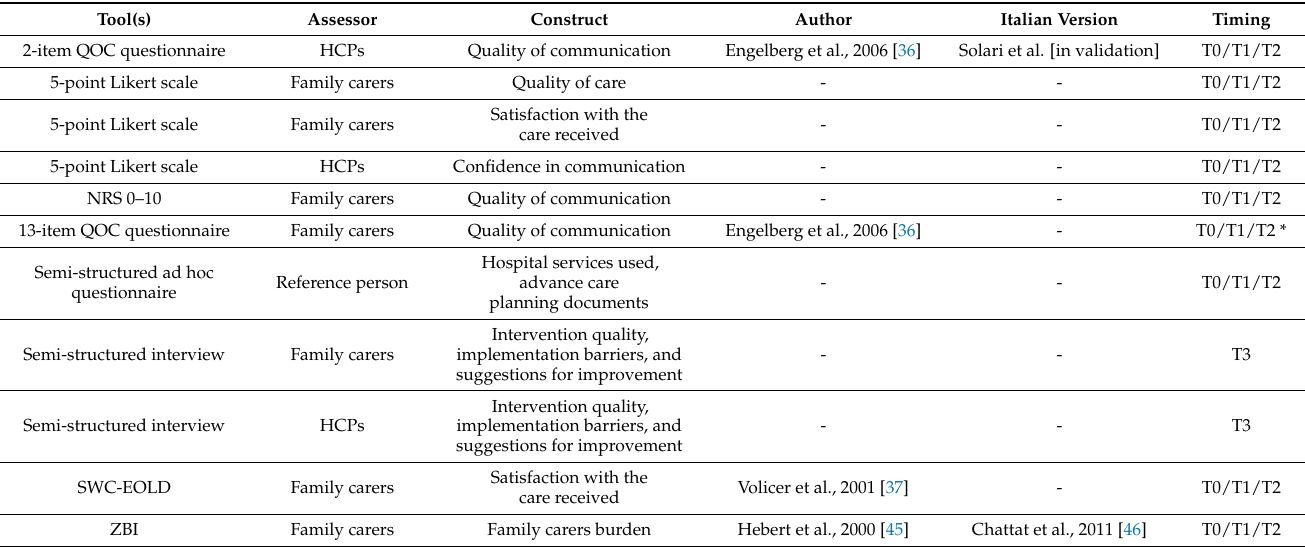
Table 2. Outcome measures (in alphabetical